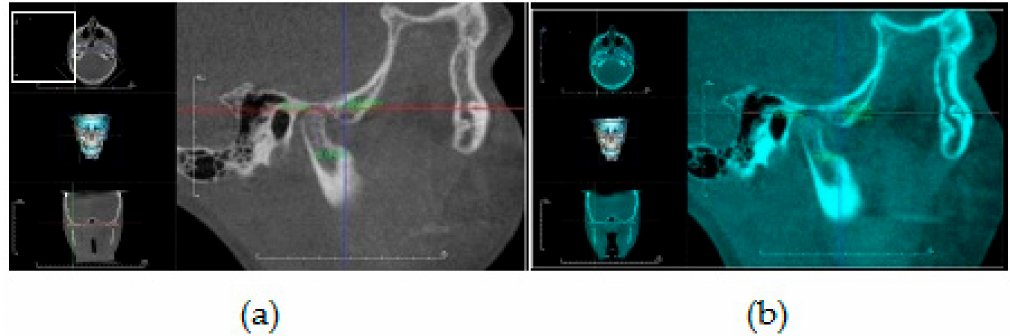
Figure 5. CBCT sagittal generated view showing assessment of condylar head position relative to VP (blue line) and FHP (red line): ( a ) before (T1) TB therapy; ( b ) after TB therapy (T2).